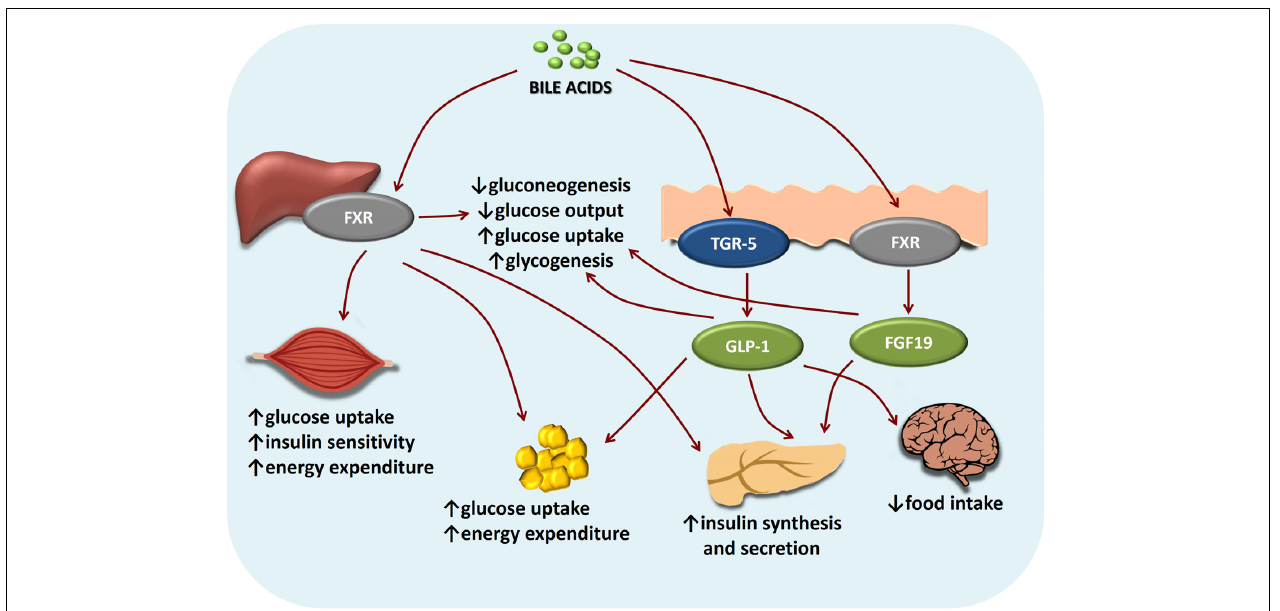
FIGURE 3 | Intertwined bile acids-mediated signaling pathways in glucose metabolism. Bile acids activation of FXR and TGR-5 signaling pathways inhibits gluconeogenesis and promotes glycogen synthesis in the liver, promotes glucose-stimulated insulin release in pancreas, increases energy expenditure especially in skeletal muscles and brown adipose tissue. In the brain, bile acids-TGR5 signaling mediates satiety.